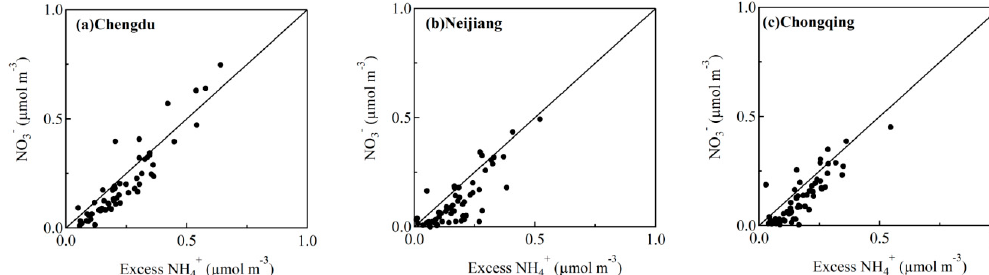
Figure 6. NO 3 − concentration as a function of excess NH 4 + in ( a ) CD, ( b ) NJ, and ( c ) CQ.